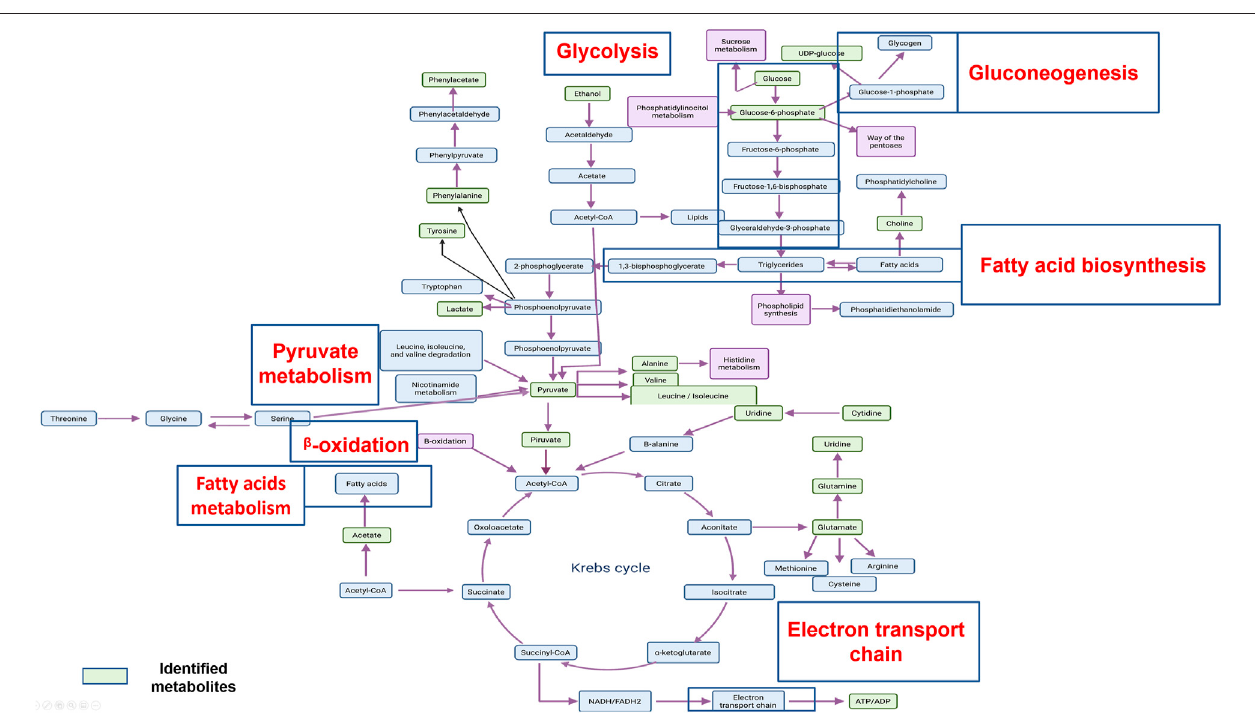
FIGURE 4 | An overview of the important cellular metabolic pathways identi fi ed in CasIIgly treatment for both treatment times.